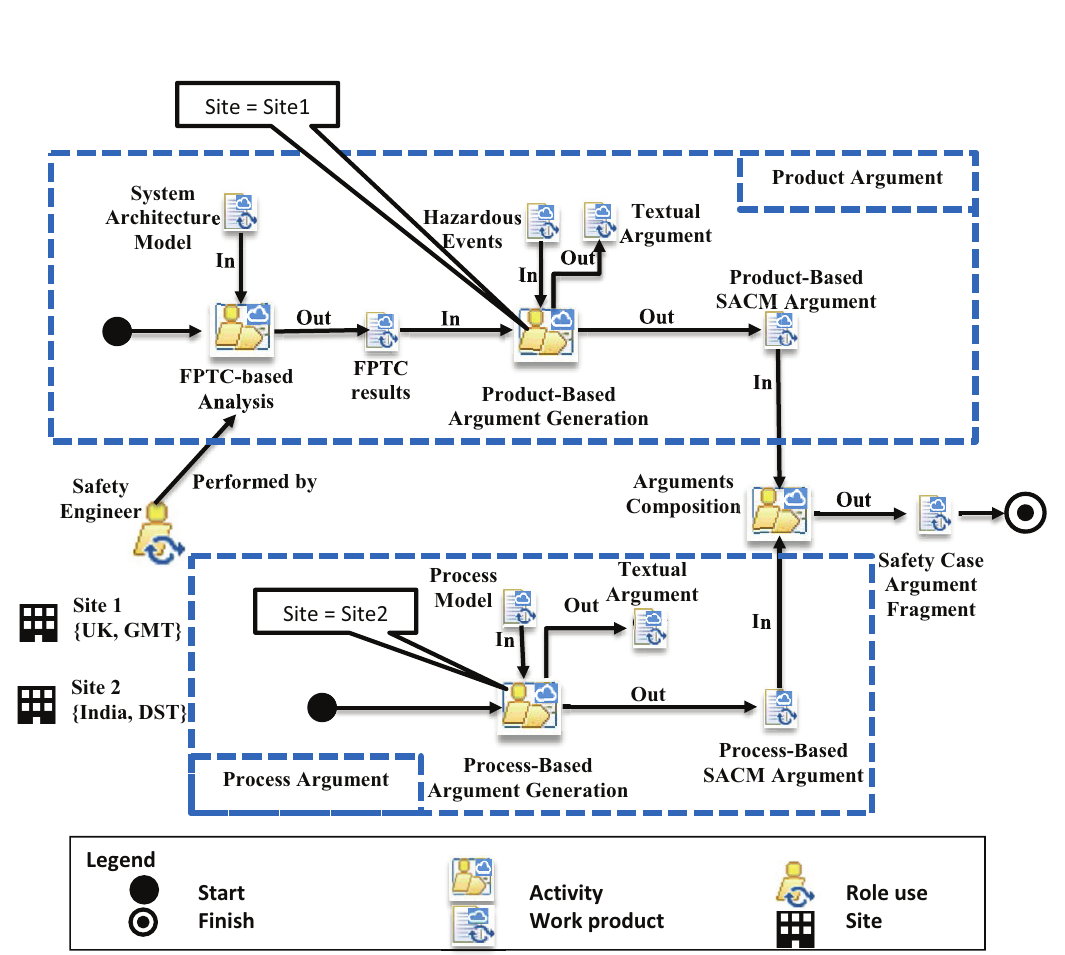
Figure 7: Safety process modelled using the extended